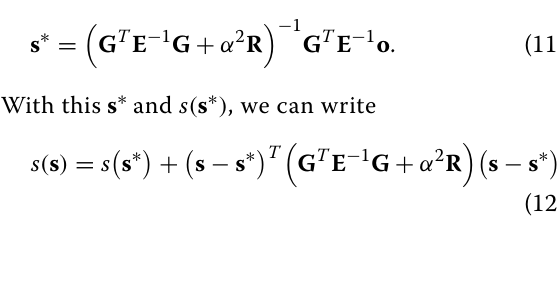
Table 1 Optimal hyper-parameters for each case